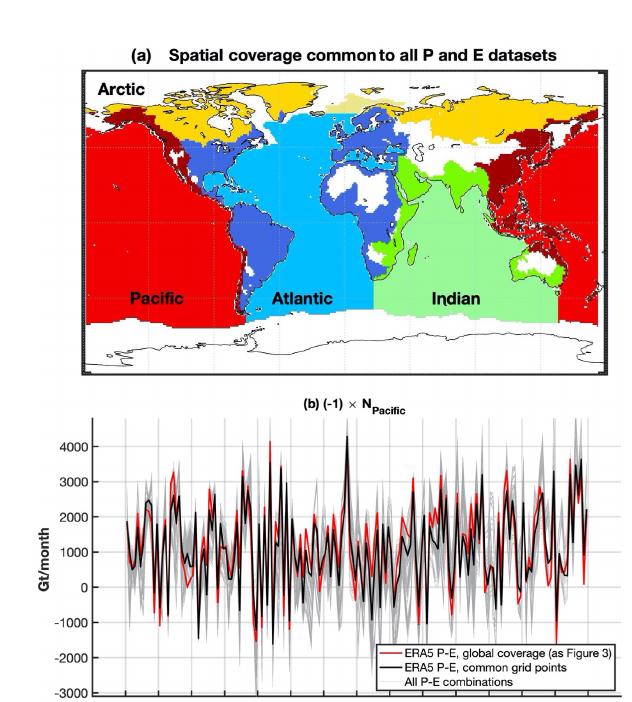
Figure 8. Monthly time series of (the opposite of) the Pacific out- flow estimated from 162 combinations of P and E datasets. (a) Spa- tial coverage common to all datasets. (b) Pacific outflows: grey thin curves are the 162 Pacific outflows estimated in the grid points com- mon to all datasets (no global coverage); black and red curves are based on ERA5 P and E and are obtained using either only the grid points common to all datasets (black curve) or global coverage (red curve). Note that the red curve is the same as in Fig. 3.